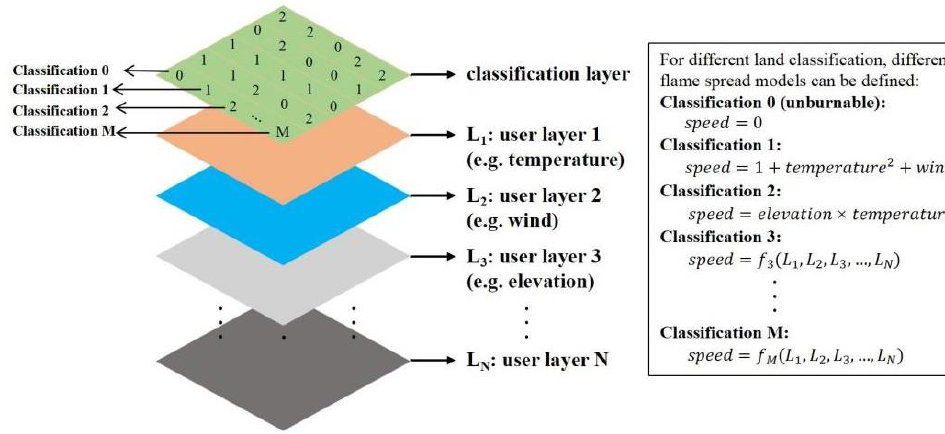
Figure 3. The schematic of bushfire predictions based on Spark.